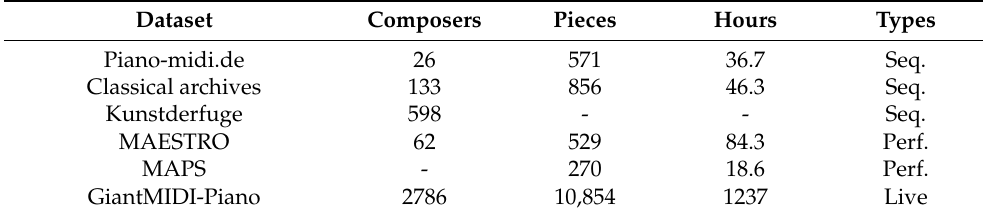
Table 1. Piano dataset